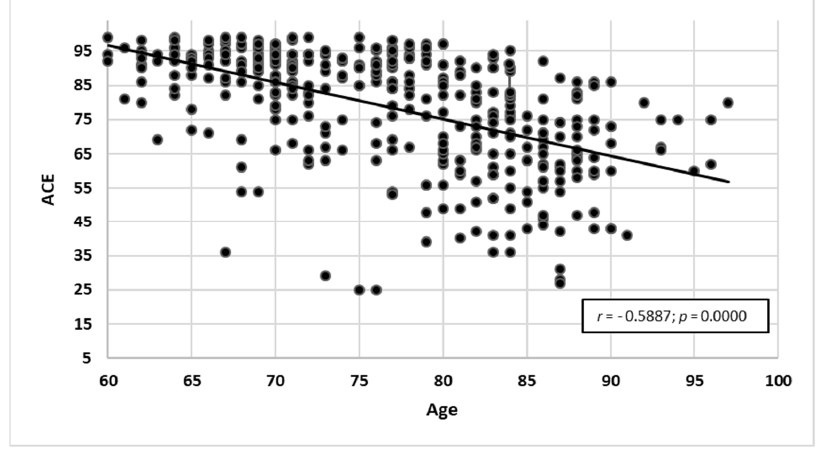
Figure 3. Age correlated with ACE-III test results ( n = 386).